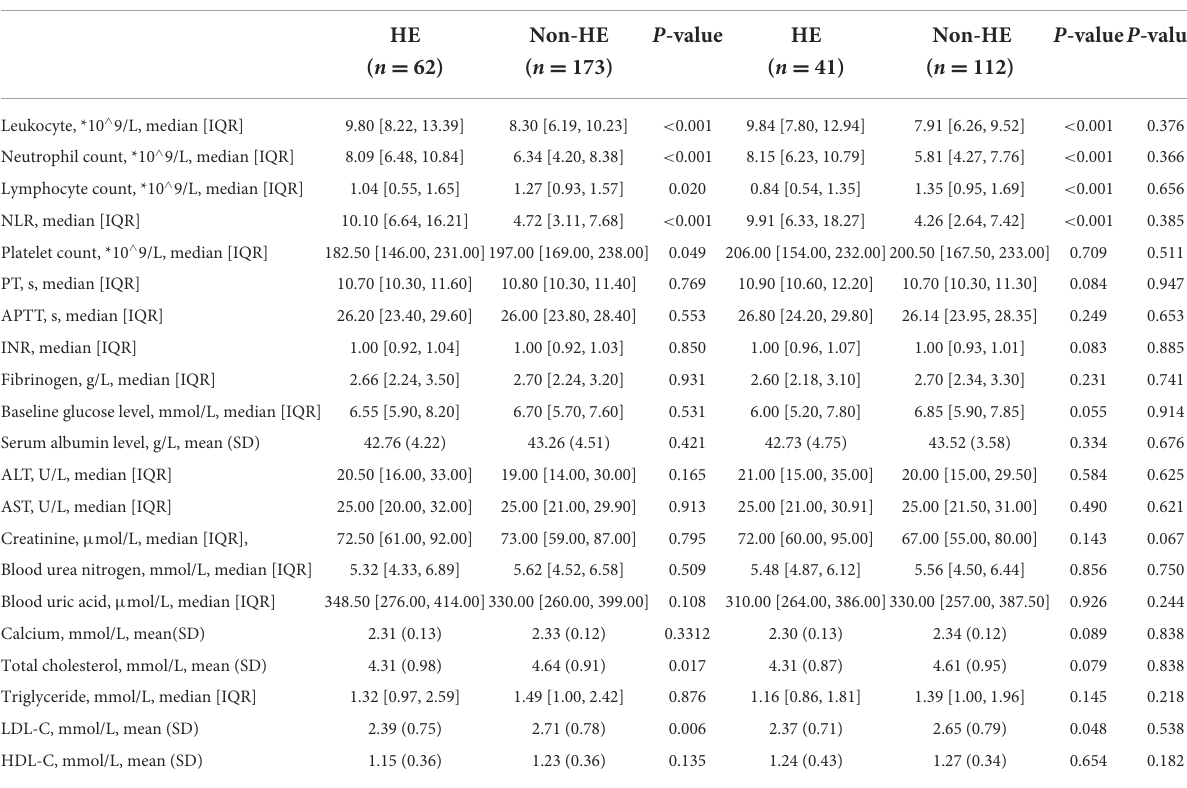
TABLE 2 Comparisons of laboratory tests between patients with and without HE.